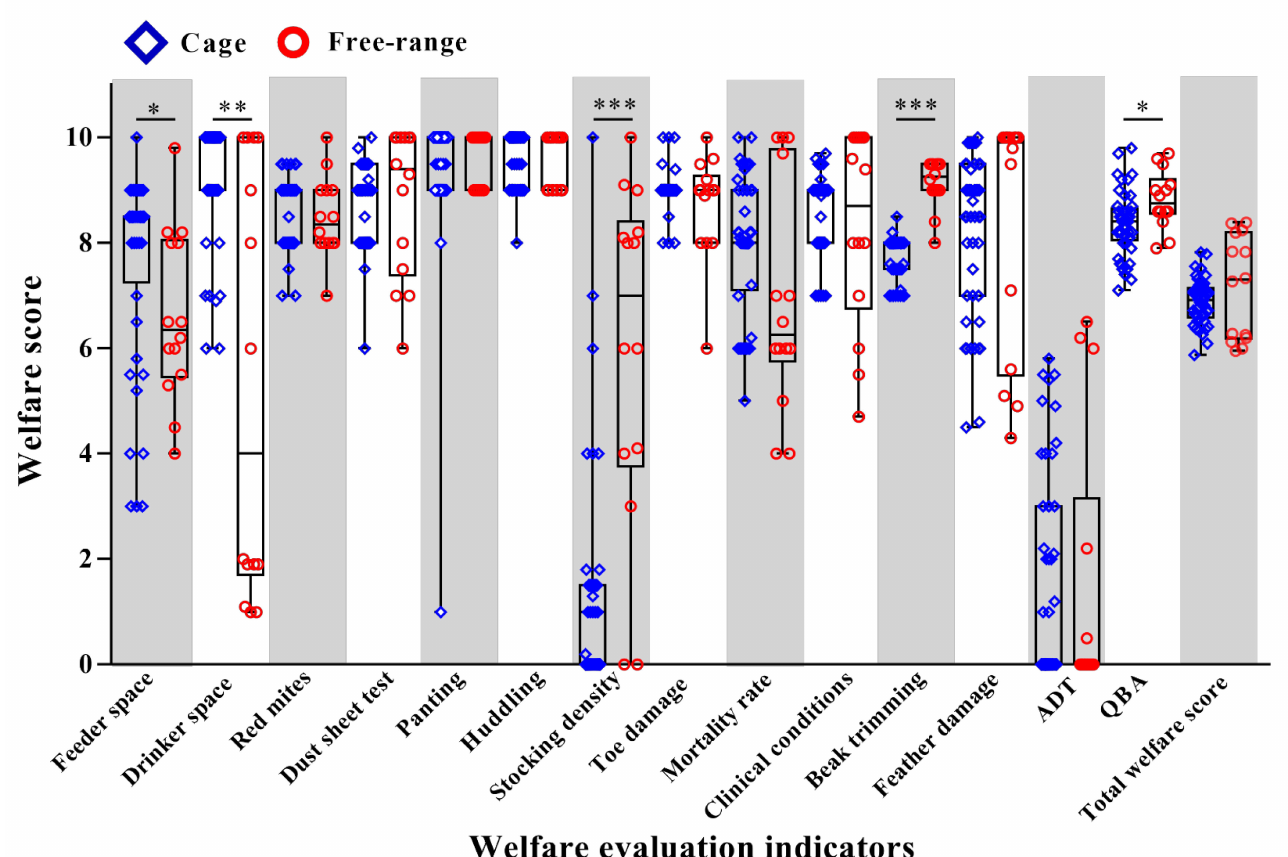
Figure 3. Welfare indicators scores for laying hen farms using caged and free-range systems. Note: ADT = avoidance distance test; QBA = qualitative behavior assessment; Significant differences are denoted by * p < 0.05; ** p < 0.01, and *** p < 0.001 using Nonparametric Mann–Whitney U